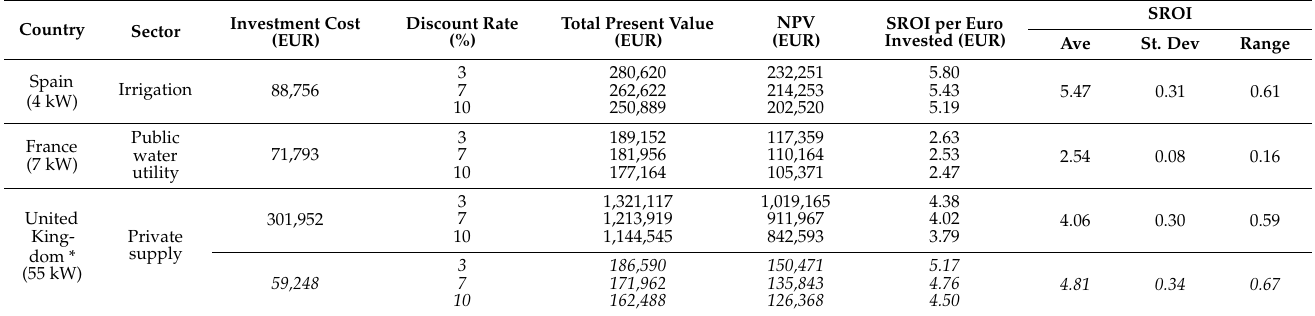
Table 6. Sensitivity of the SROI results of the MHPMHP cases to discount